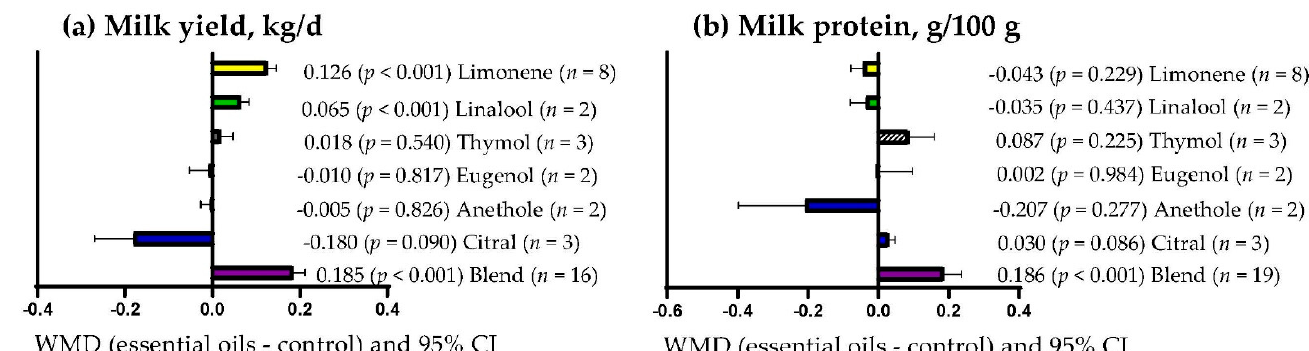
Figure 5. Subgroup analysis (subgroup = primary bioactive compound) of the effect of essential oils supplementation to small ruminants’ diets on their blood metabolites; WMD = weighted mean differences between essential oil treatments and control.